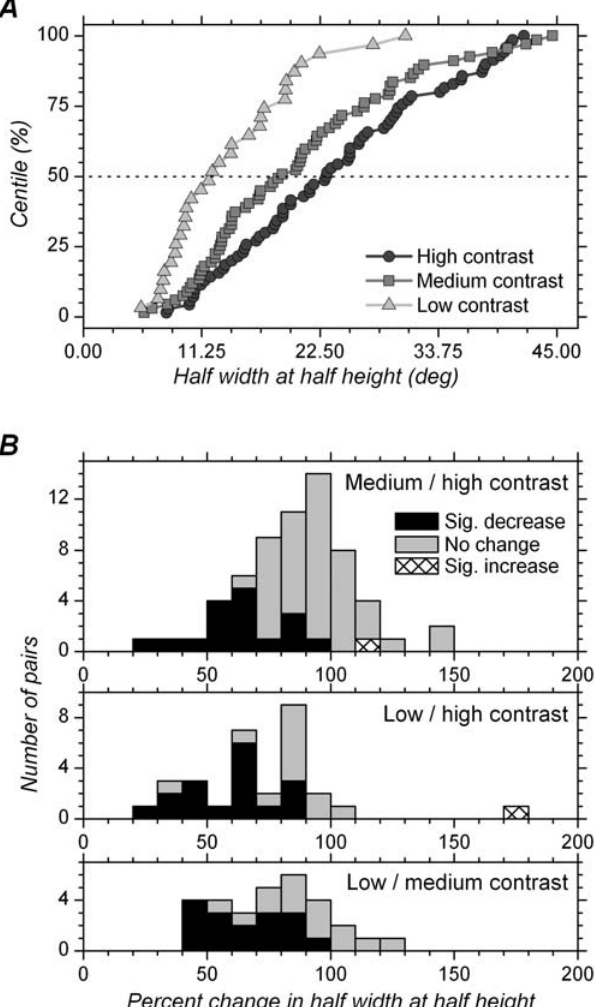
Figure 8. Changes in orientation tuning width with different contrasts in mixed contrasts blocks. A. Cumulative distribution of HWHH for the three different contrasts. Horizontal dashed line corresponds to the median. B. Distribution of percent change in HWHH with different contrasts. HWHH for medium contrast is expressed as a percentage of the HWHH at high contrast in the upper histogram. HWHH for low contrast is expressed as a percentage of the HWHH at high contrast in the middle histogram, and as a percentage of the HWHH at medium contrast in the lower histogram. 100% on x -axis corresponds to no change in HWHH. Relative to 100%, all distributions are shifted to the left, indicating decreased HWHH with decreased contrast. Black bars in histograms correspond to significant decrease in HWHH when contrast decreases, and hatched bars to significant increase in HWHH, tested at the single cell level (p , 0.05, t test).